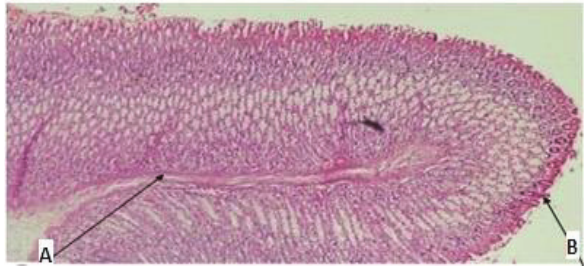
Fig-3: H &E stained slide of omeprazole group showing